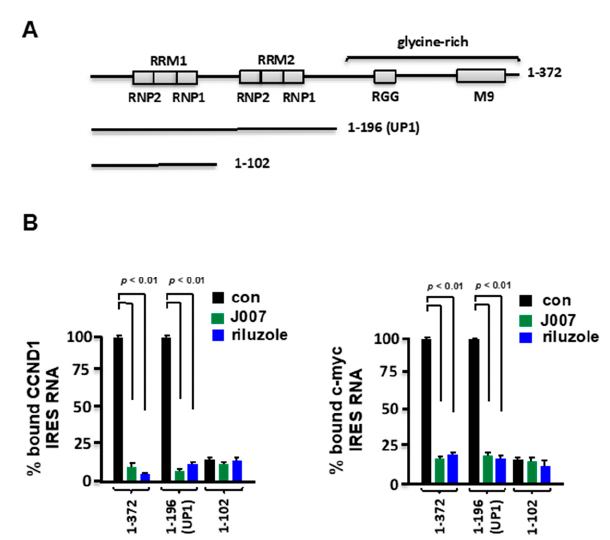
Figure 3. Riluzole-mediated inhibition of hnRNP A1 ITAF / IRES-binding requires only the UP1 fragment. ( A ) Schematic representation of GST-tagged hnRNP A1 deletion mutants. Mutant 1-196 constitutes the UP1 fragment of full-length human hnRNP A1. In the ∆ 130–158 mutant, the sequences encompassing RRM2 have been deleted. ( B ) Binding of either cyclin D1 (left panel) or c-MYC (right panel) IRES RNAs to GST-tagged hnRNP A1 mutants in the absence or presence of C11 or IRES-J007 as assayed by filter binding. Mean and +SD are shown for three independent experiments.